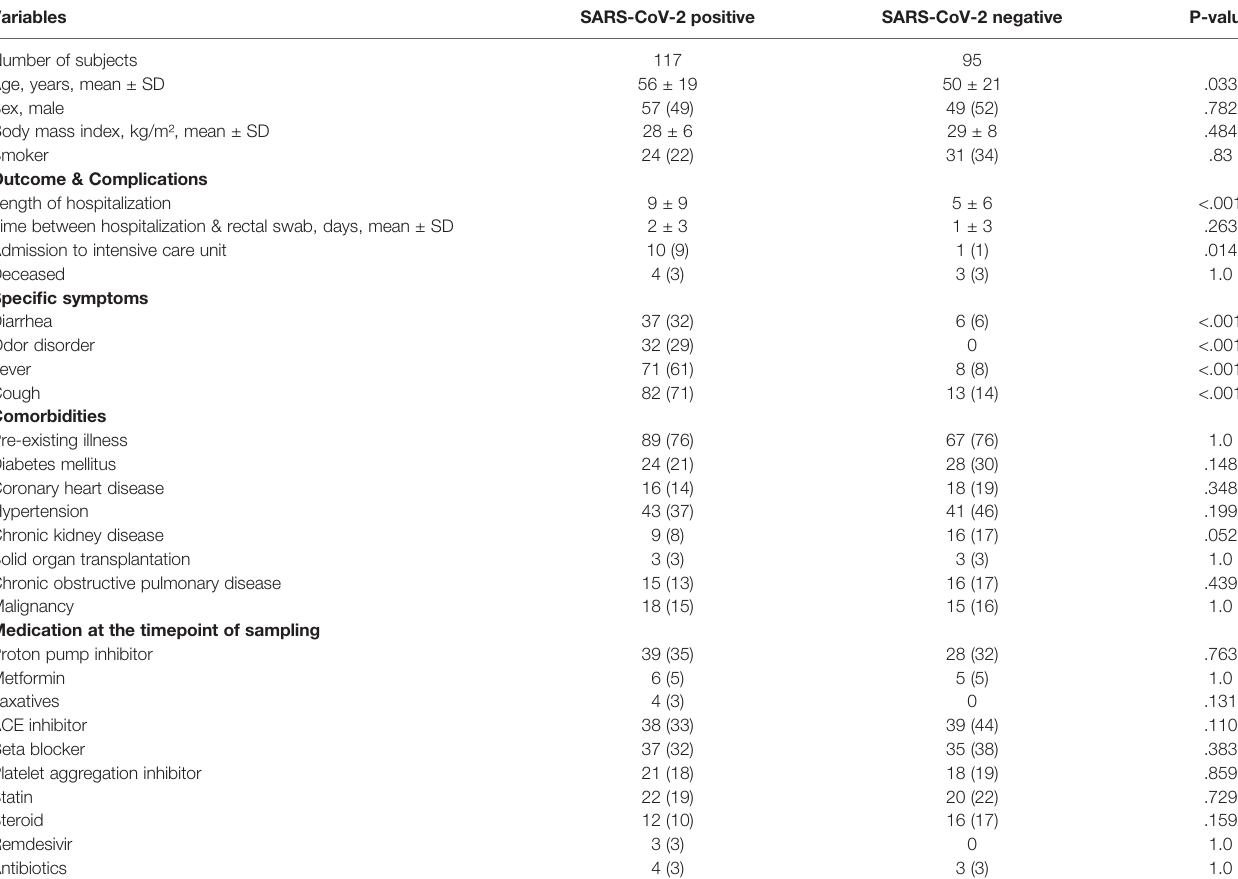
TABLE 1 | Patient characteristics of SARS-CoV-2 positive and negative